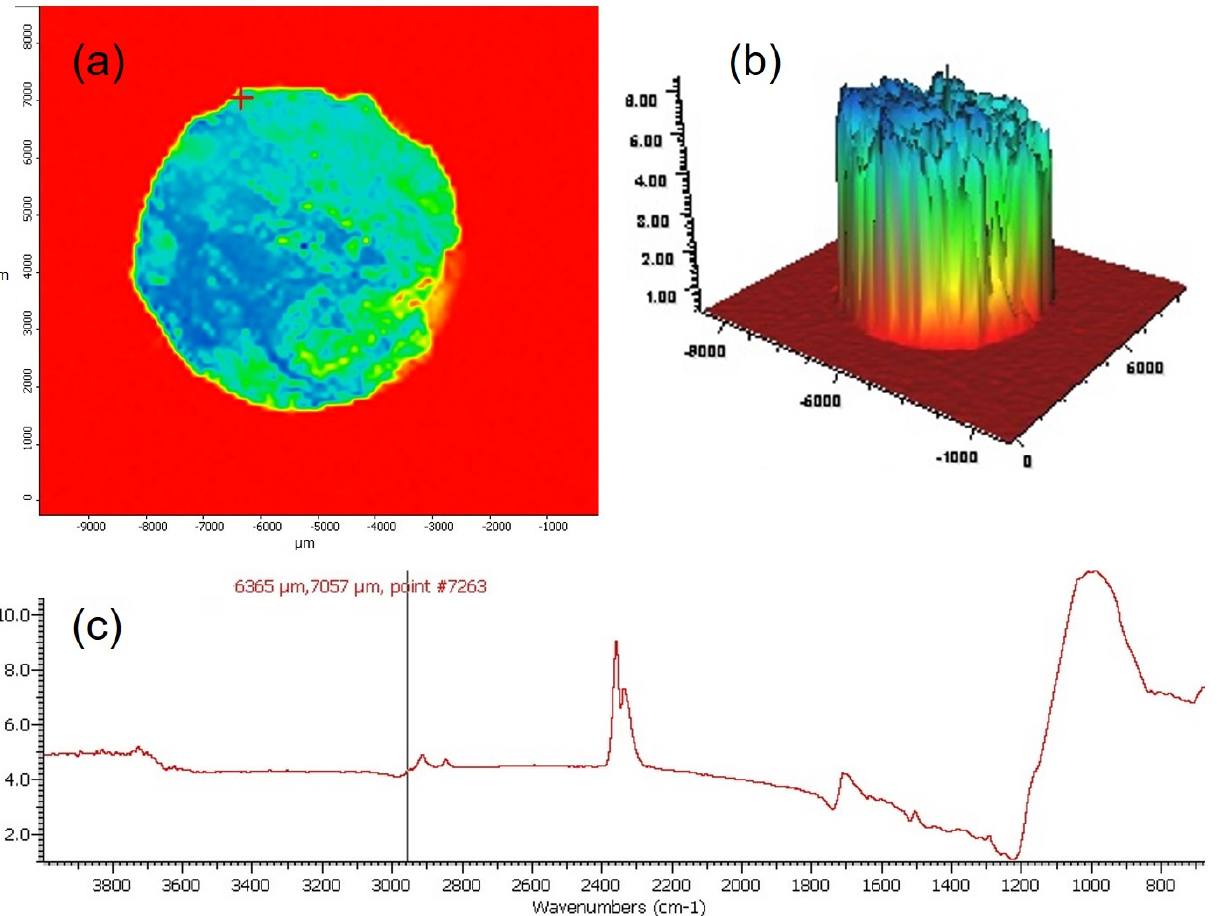
Figure 10. Results of FTIR mapping tests, in which the composite samples were exposed to the continuous mode for 5 s: ( a ) chemical map obtained using the correlation method based on the peak at the position of 2960 cm − 1 , ( b ) 3D mapping image; ( c ) FTIR spectrum obtained using the specular reflection technique.